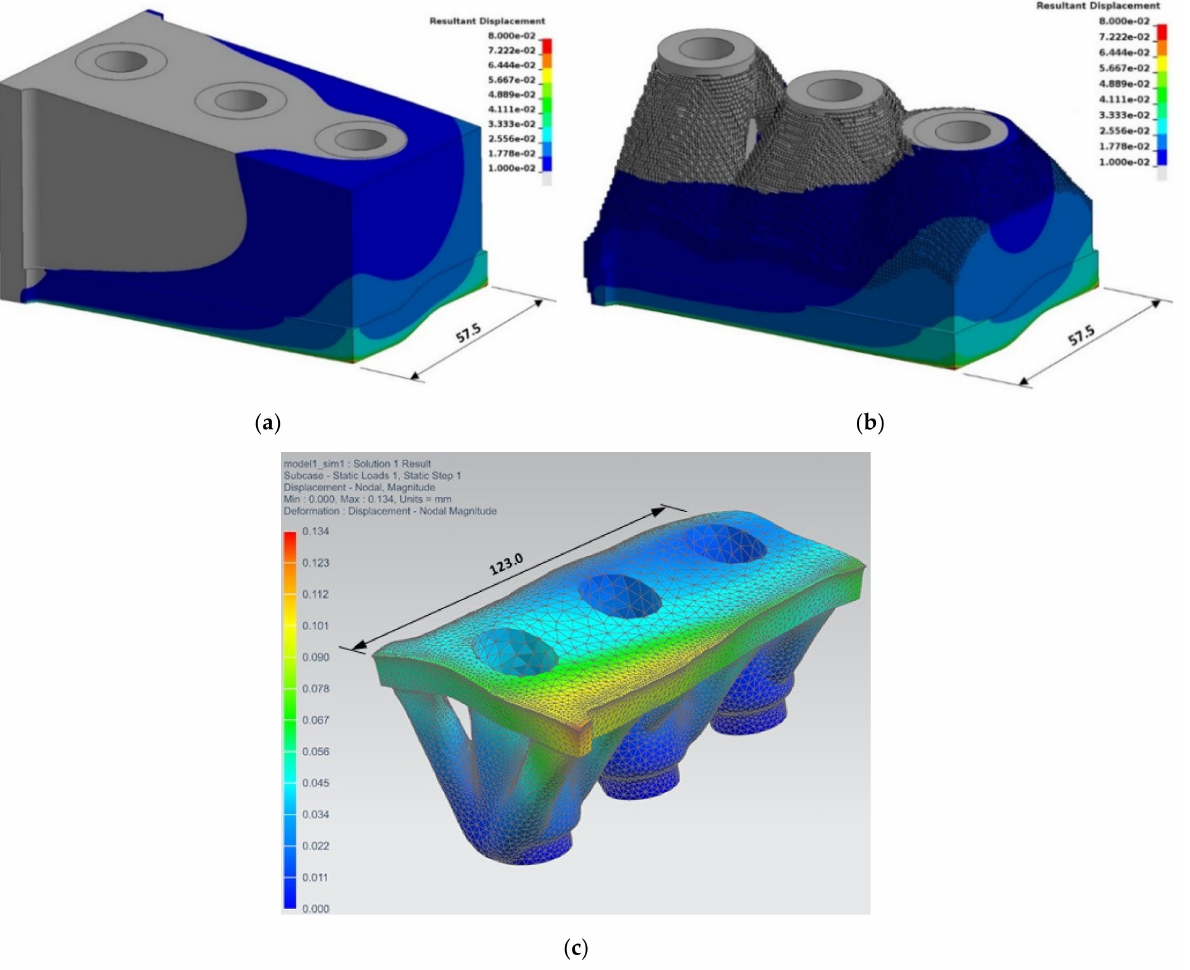
Figure 14. The shape and the resultant displacements prior to unloading in the punch ( a ) with the original design and ( b ) topology optimized with the volume fraction 0.45 using LS-TaSC, and ( c ) topology optimized using NX12 and targeting a weight reduction by 70% (compared to the conventionally designed solid version) [62,131]. All displayed dimensions are in